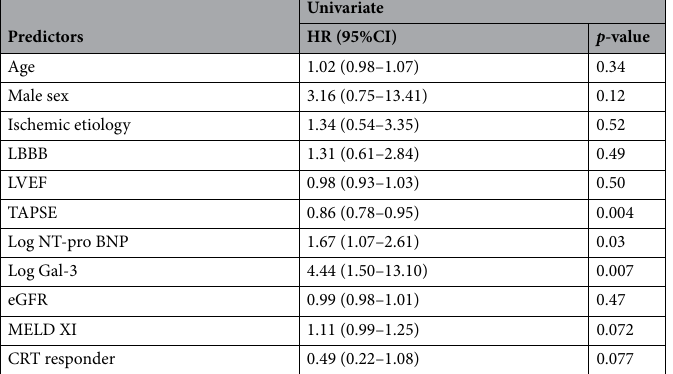
Table 4. Cox proportional hazards univariate analyses to identify predictors of death. HR, hazard ratio; CI, confidence interval. LBBB, left bundle branch block; Gal-3, galectin-3; TAPSE, tricuspid annular plane systolic excursion; NT-pro BNP, N-terminal pro B-type natriuretic peptide; eGFR, estimated glomerular filtration rate; LVEF, left ventricular ejection fraction; MELD-XI, Model for End-Stage Liver Disease eXcluding INR; CRT, cardiac resynchronization therapy.